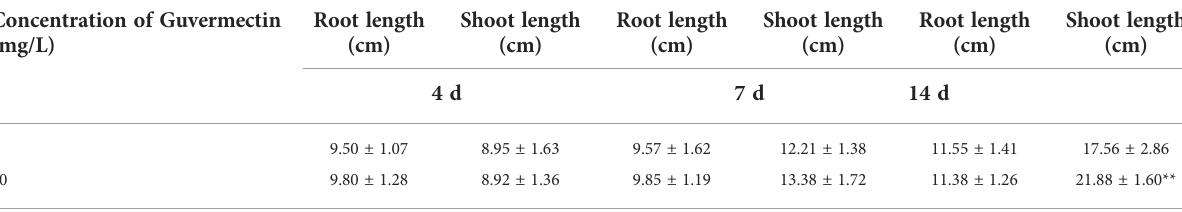
TABLE 1 The effects of guvermectin treatment on the maize seedlings growth in paper roll culture system. Concentration of Guvermectin (mg/L)